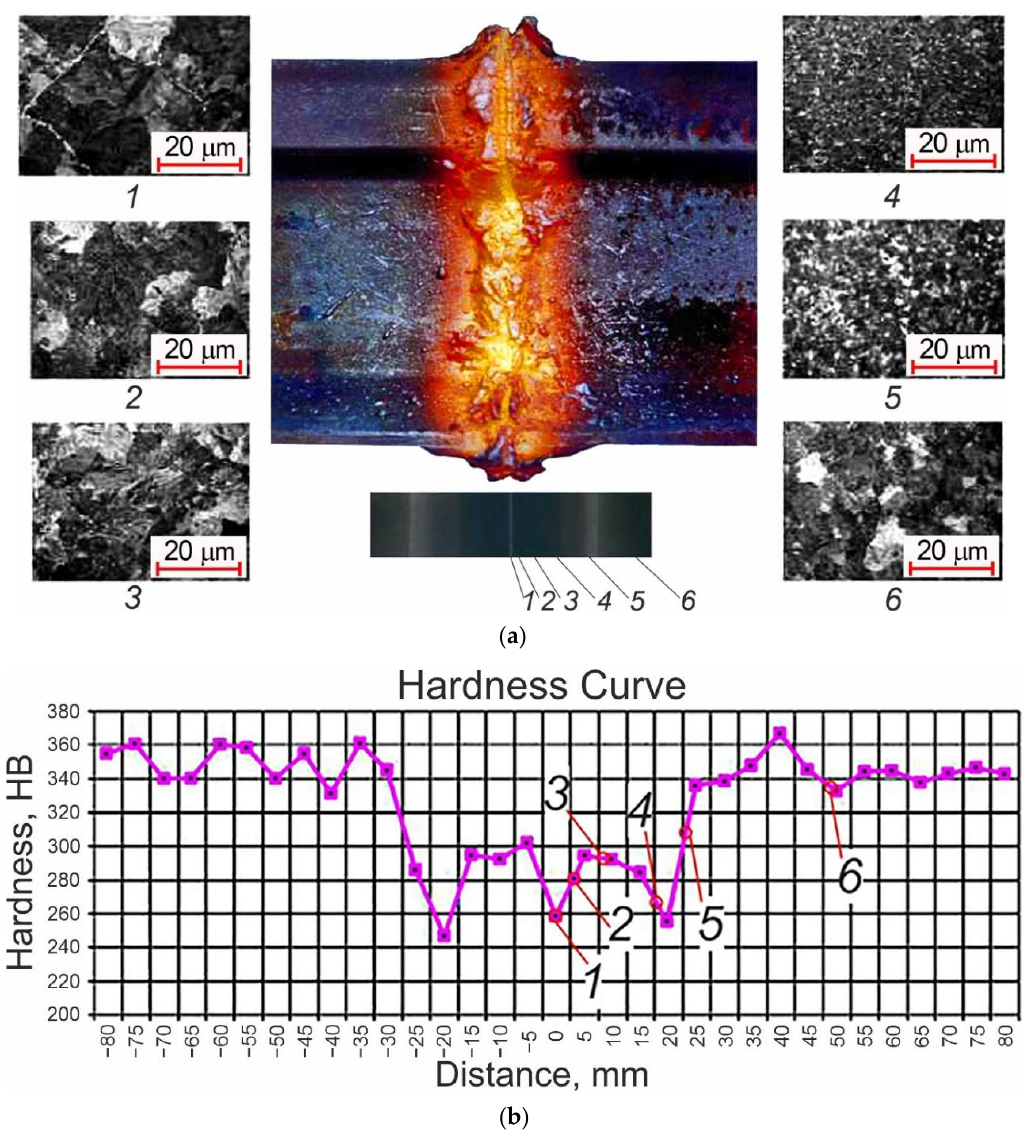
Figure 3. Macro- and microstructure in pulsating flesh welding ( a ), hardness distribution of the welded joint of rails; ( b ): 1 — weld seam; 2, 3, 4, 5 — zones of incomplete metal melting, respectively, formation of a fine eutectoid mixture of pearlite and cementite after overheating, formation of a fine eutectoid mixture of pearlite and cementite without overheating of high tempering; 6 — base metal. Thermal modes mainly prevent cold cracks caused by a number of factors, such as the formation of quenching structures (martensite and bainite), which leads to the appear- ance of additional stresses due to the volumetric effect. Diffusion and concentration of hydrogen, which is adsorbed in microvoids, causes additional embrittlement of the metal [20]. In the case of thermal impacts on the metal in the heat-affected area, the nature of structural transformations largely depends on the mass fraction of elements included in the chemical composition of steel, and the cooling rate. With an increase in the cooling rate, the resulting structure in the heat-affected area is crushed and its hardness increases. If the cooling rate exceeds the critical rate, the formation of quenching structures is inevi- table. Quenching structures may also form quenching cracks. Plastic, well-treated structures, such as pearlite or finely dispersed eutectoid mixture of pearlite and cementite, are most desirable in the heat-affected area. The conducted experiment on welding a rail made of the E76HGF steel showed that the heat-affected zone was approximately 30 – 40 mm, which corresponds to standard val- ues. Zone 1 in Figure 3 is the center of the weld seam with the structure of coarse-grained lamellar pearlite with a ferritic mesh around the former austenitic grains. Such a structure will provide a relatively low hardness and good plasticity. Zone 2 is a zone of incomplete melting and its structure is similar to the structure of the first zone; however, the ferritic grid is not solid, but in the form of fragments. Pearlite grains are smaller and less decar- bonized steel. As a result, the hardness drop gradient magnitude is not as large as in the first zone. The structure of zone 3 is a coarse-grained lamellar eutectoid mixture of pearl- ite, cementite and alloyed ferrite. In zone 4, this eutectoid mixture of pearlite and cement- ite turns into austenite. During recrystallization, a relatively fine grain is formed. The hardness in zones 2 – 4 is practically at the same level. In zone 5, high tempering occurs, which significantly reduces the steel hardness and provides a ferrite – pearlite structure. The main technological method that reduces the likelihood of cracks is heating. The heating temperature is determined depending on the carbon equivalent and the cross- sectional area of the rail. The required heating temperature increases with the increase in steel alloying and the rail cross-sectional area. Heating promotes pearlite conversion and is an effective means of eliminating quenching structures. Therefore, it serves as a prelim- inary heat treatment of welded joints (heating before and during welding). If we change the heating process, we can control the cooling rate and obtain the desired hardness in the HAZ.